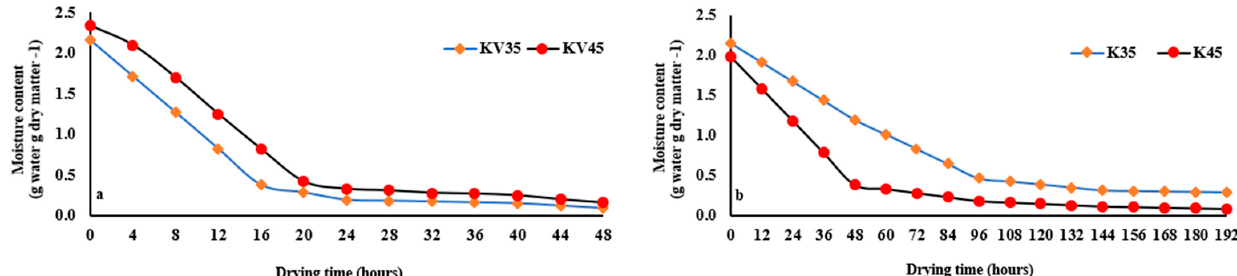
Figure 4. Drying curves according to moisture content versus drying time for KV35-KV45 ( a ) and K35-K45 ( b ) samples.